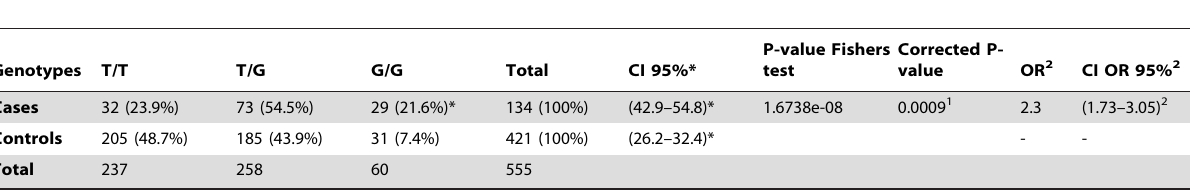
Table 4. Distribution of MDM2 T309G polymorphism in the whole